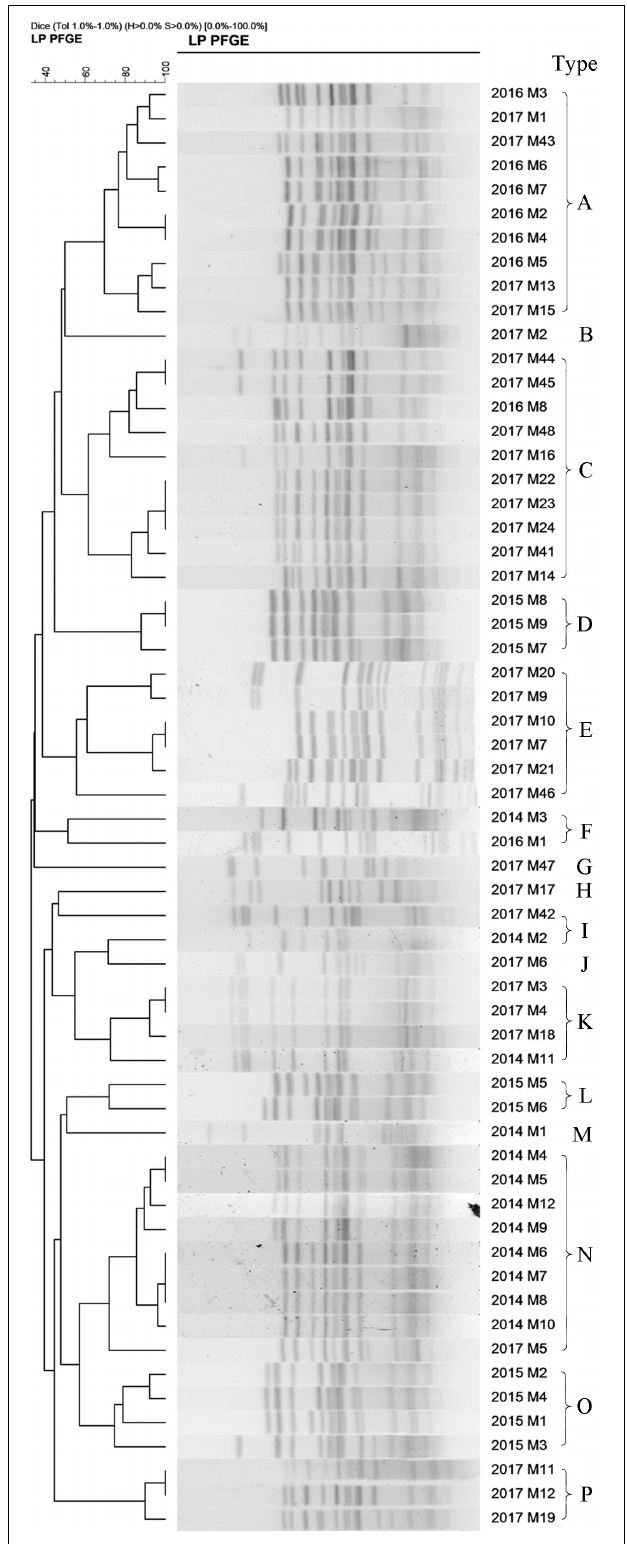
FIGURE 6 | The 60 S . Typhimurium strains collected from 2014 to 2017 were classify into 16 types (A–P) based on a > 60% similarity ( Endonuclease Xba I).